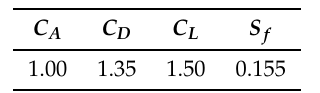
Table 1. Hydrodynamic parameters employed in the present study.